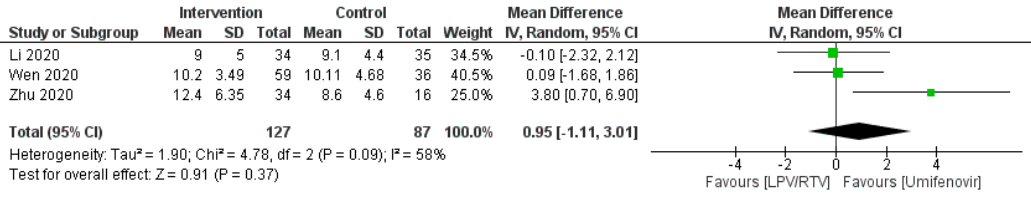
Figure 3. Time from +ve to − ve PCR (days) (LPV/RTV vs. umifenovir). CI, confidence interval; df, degrees of freedom; LPV/RTV,